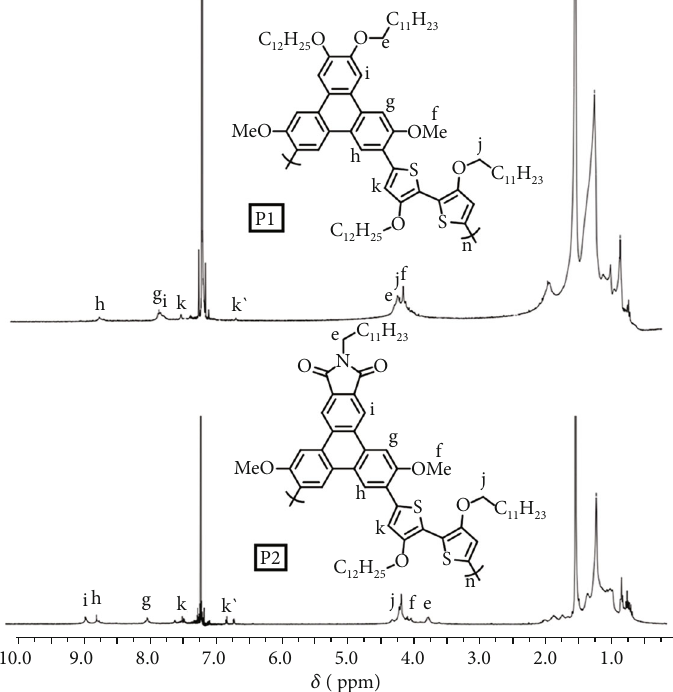
Figure 2: 1 H NMR spectra of the two polymers P1 and P2 .